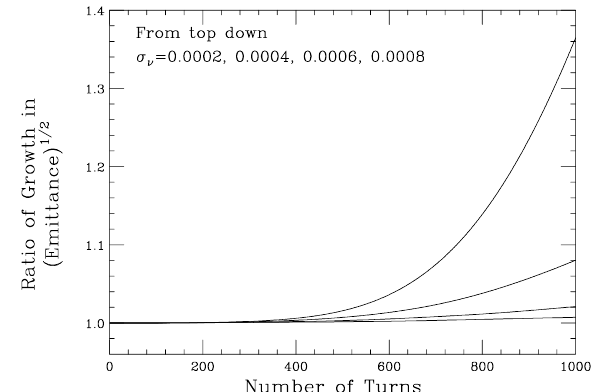
FIG. 17. Total growth of the 13-cm bunch within the 1000 turns in the presence of an amplitude dependent tune shift, such as provided by an octupole. The maximum growths are 1.36, 1.08, 1.02, and 1.007, respectively, for rms tune spread (cid:1) 0.0002 , 0.0004, 0.0006, and 0.0008. An average of s n b betatron function of (cid:8) b (cid:9) (cid:1) 20 m has been assumed.